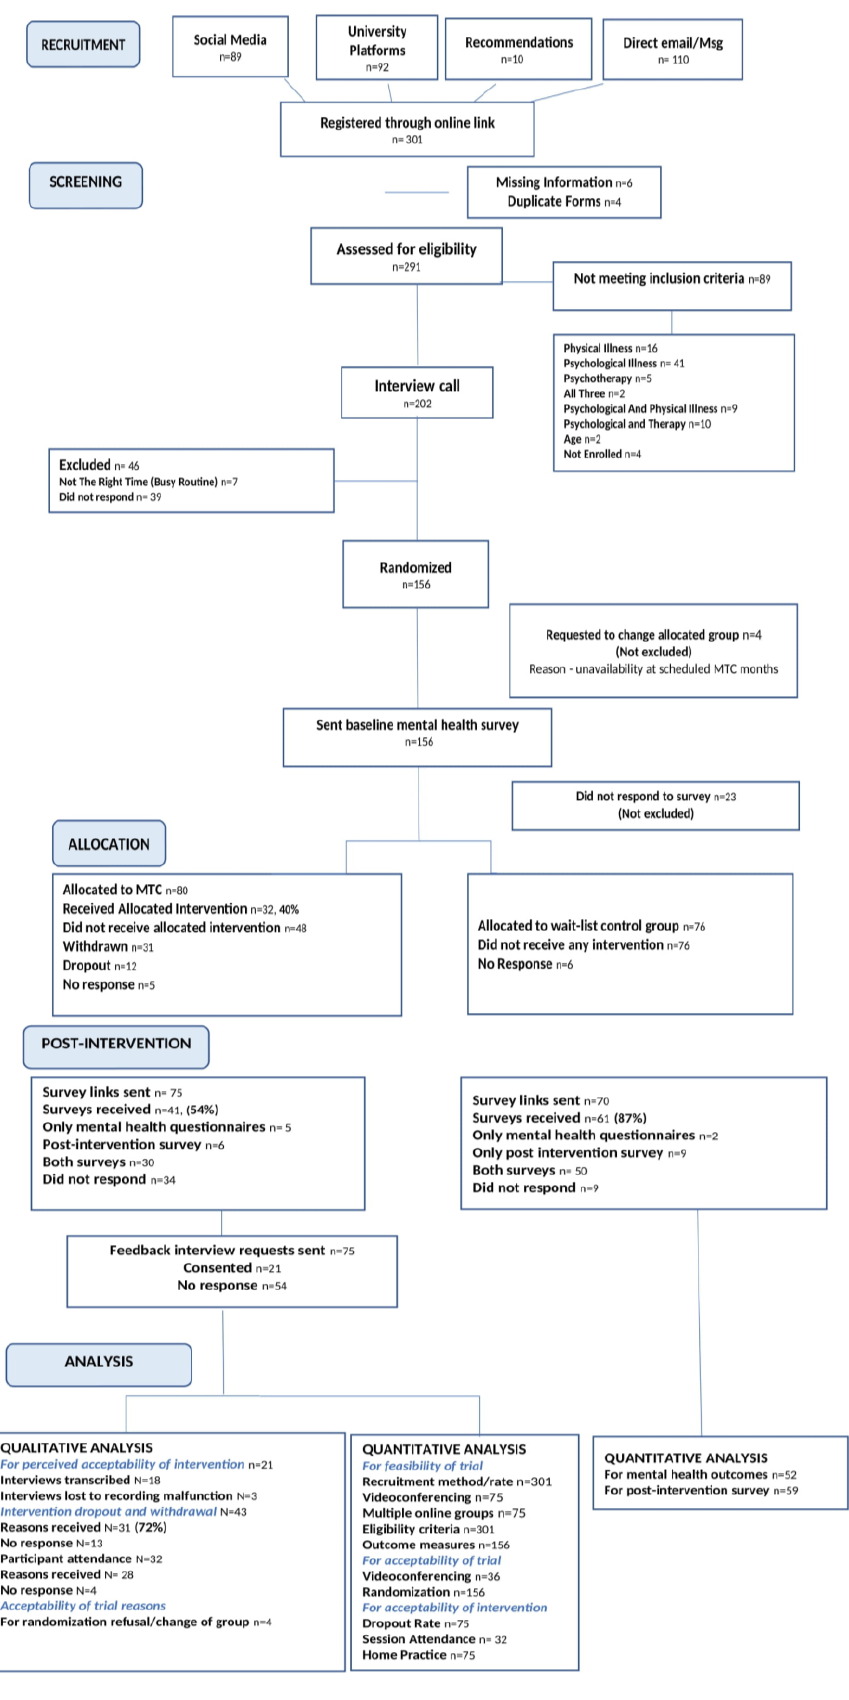
Figure 1. CONSORT Flow diagram for pilot randomized control trial of a Mindfulness Training Course for university students.